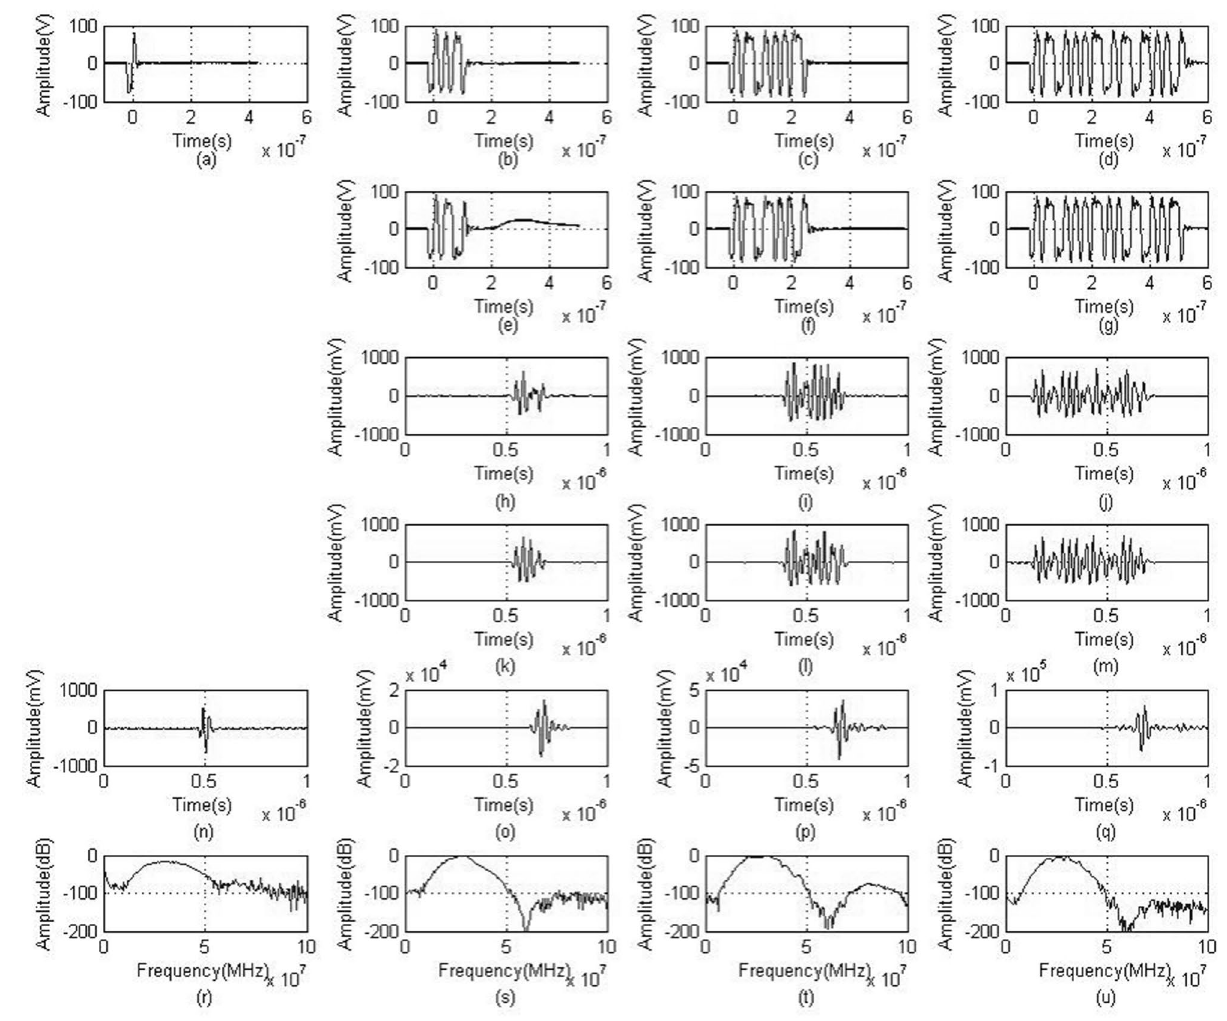
Figure 2. Experimental results of wire target echoes. ( a ) Single-pulse transmission waveforms. ( b – d ) are respectively the 4-bit, 8-bit, and 16-bit Golay sequence A coded transmission waveforms. ( e – g ) are respectively the 4-bit, 8-bit, and 16-bit Golay sequence B coded transmission waveforms. ( h – j ) are respectively the 4-bit, 8-bit, and 16-bit Golay sequence A coded return echoes. ( k – m ) are respectively the 4-bit, 8-bit, and 16-bit Golay sequence B coded return echoes. ( n ) is the return echo of a single pulse. ( o – q ) are respectively the 4-bit, 8-bit, and 16-bit Golay sequence decoded return echoes. ( r – u ) are respectively the frequency spectra of the single- pulse echo and the 4-bit, 8-bit, and 16-bit Golay sequence